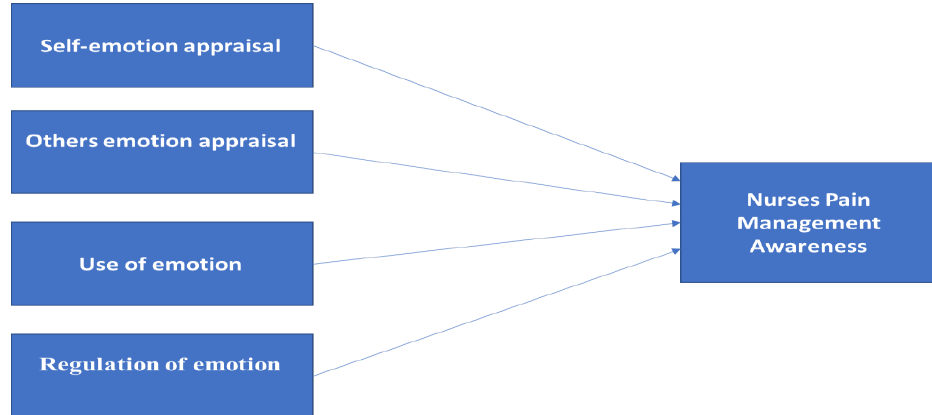
Figure 1. Research framework on the relationship between emotional intelligence and nurses pain management awareness.